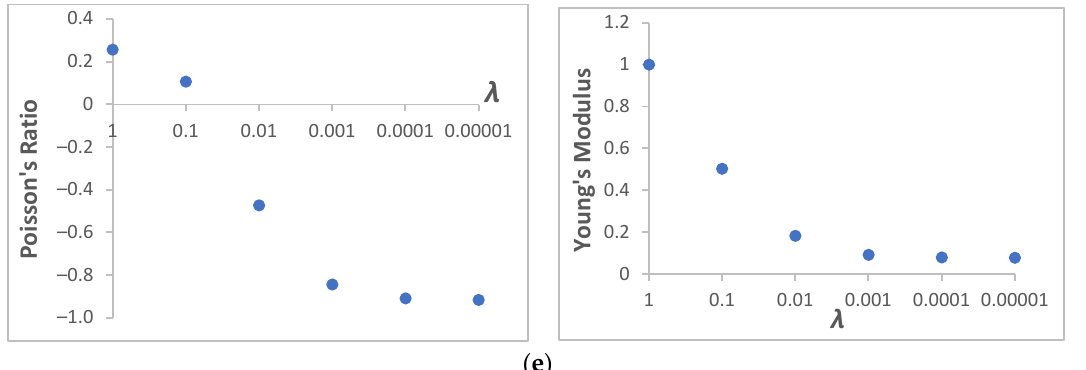
Figure 7. Effects of design parameters ( a ) θ , ( b ) g , ( c ) s , ( d ) t , and ( e ) λ on Poisson’s ratio and Young’s modulus of the bi-material plate.